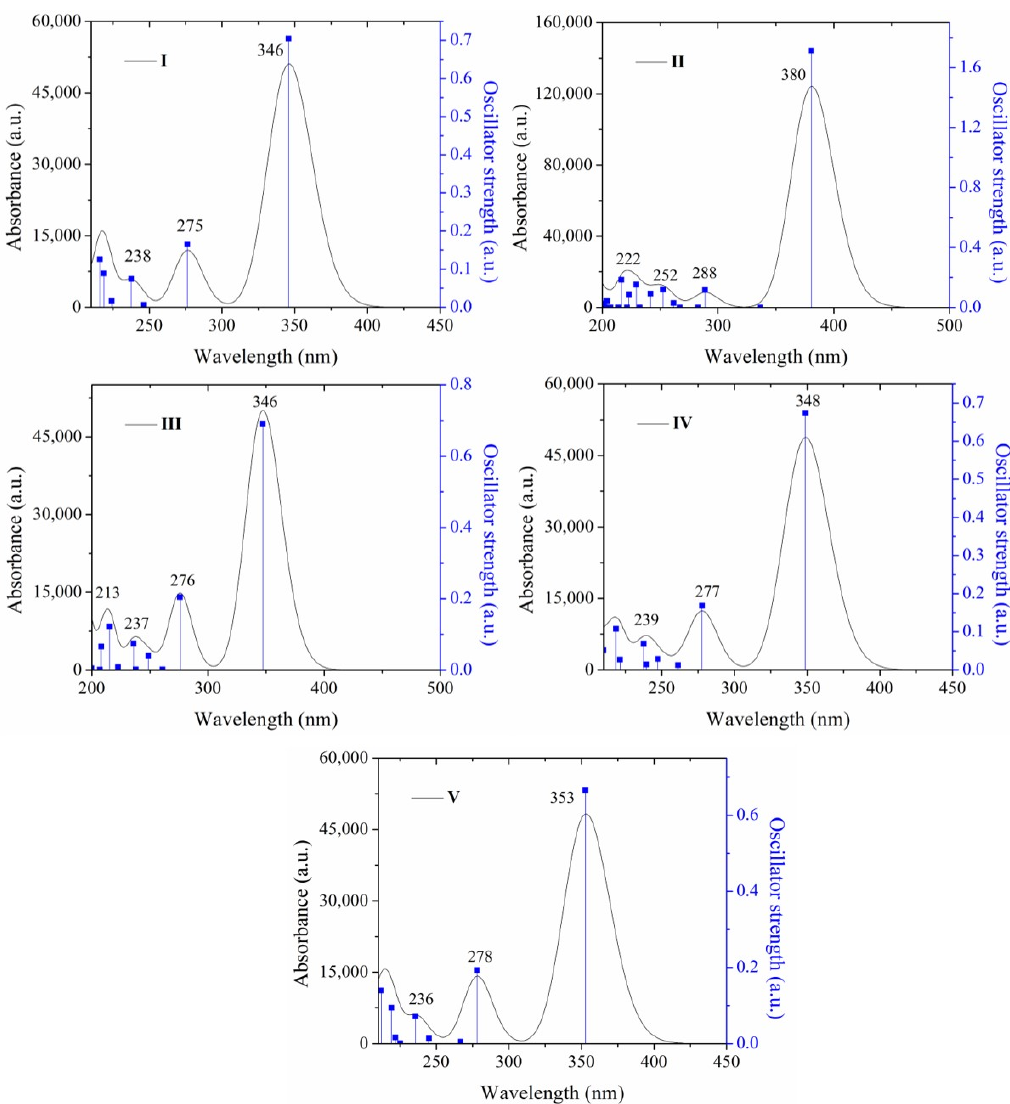
Figure 3. Absorption spectra of I – V calculated at a theoretical level of M062x/cc-pVTZ in the gas state.